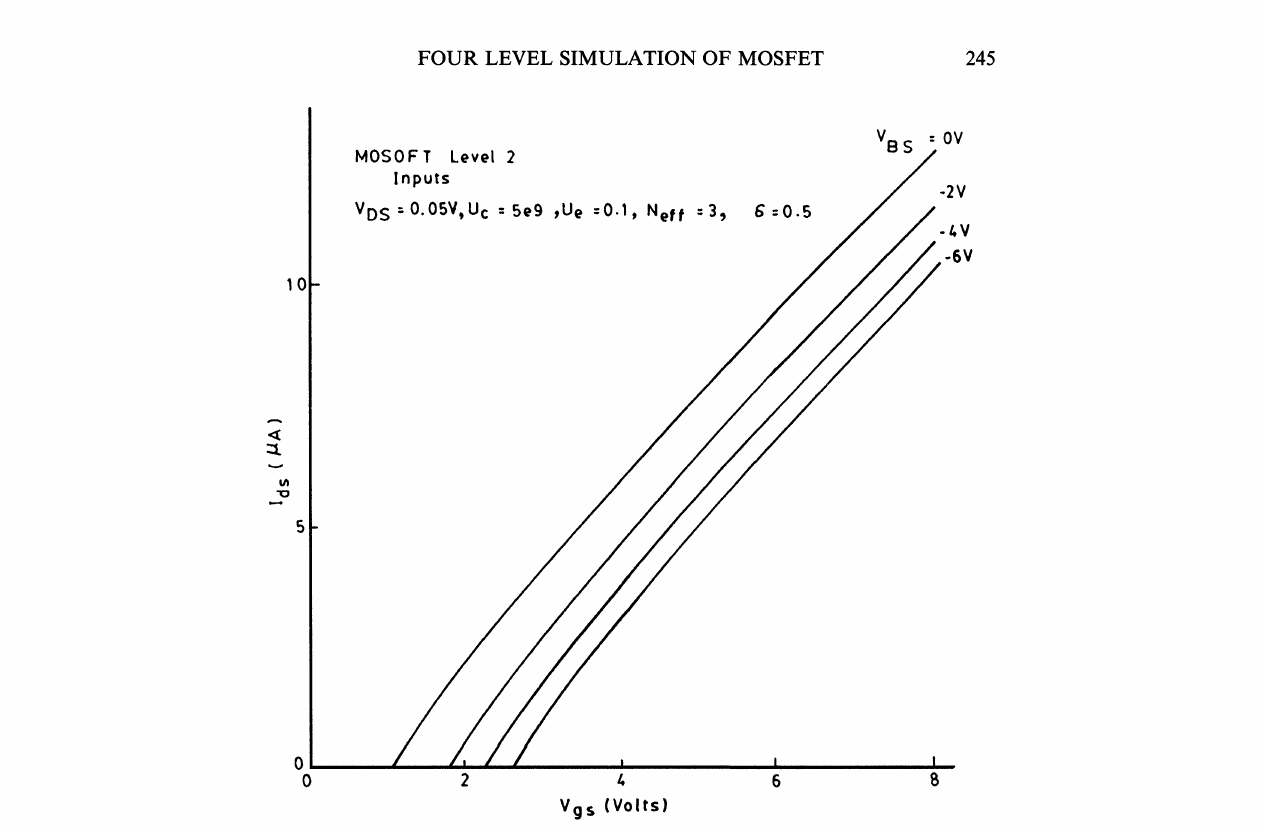
FIGURE 10 Graph drawn by using MOSOFT equations for the values of the various parameters as